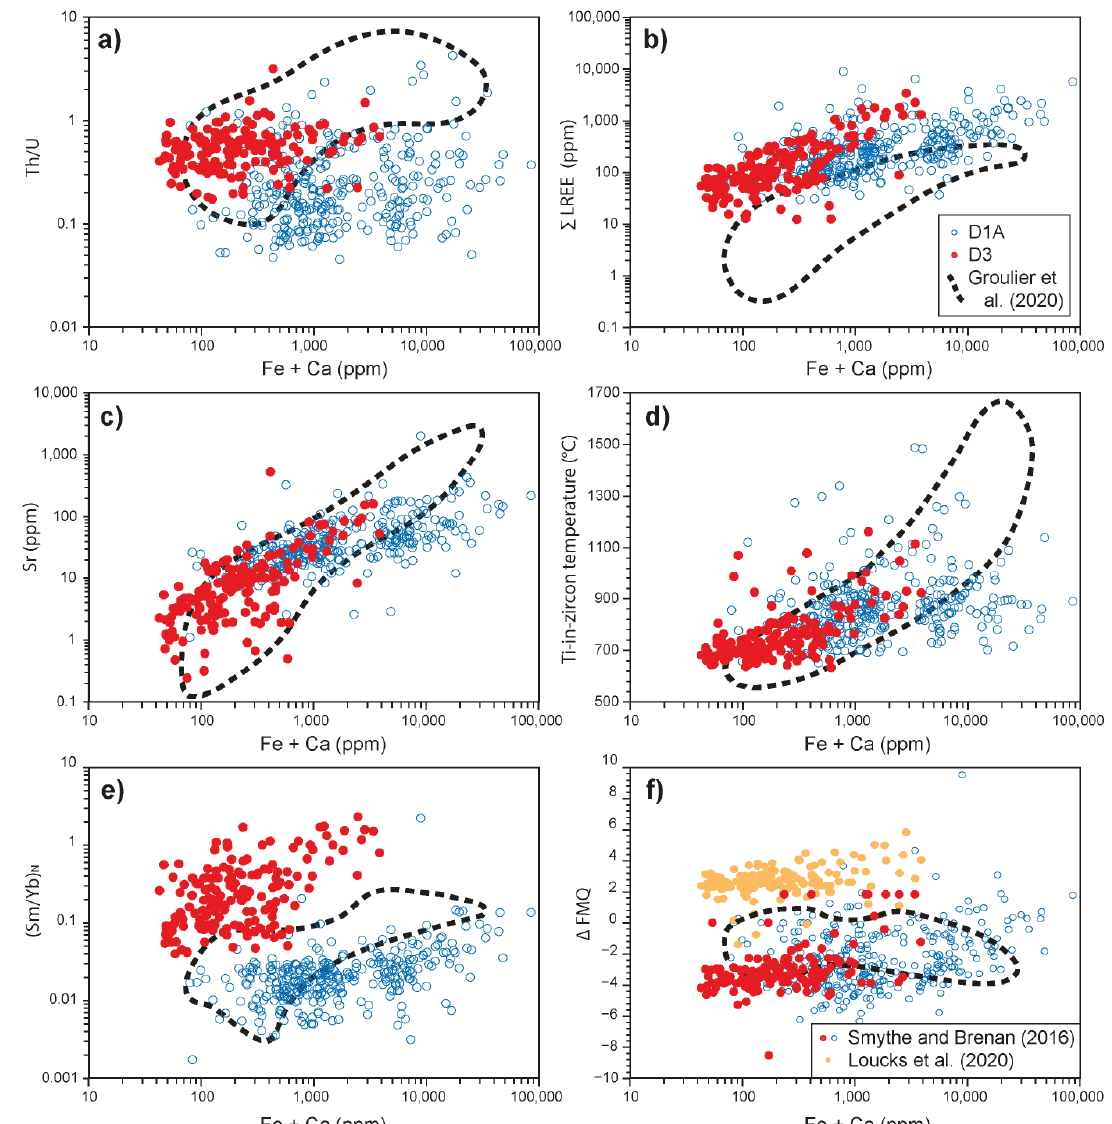
Figure 11. Chemical composition of the studied zircon grains displayed on the binary diagrams Fe + Ca vs. ( a ) Th/U, ( b ) sum LREE, ( c ) Sr, ( d ) temperature, ( e ) (Sm/Yb) N , and ( f ) oxidation state. Samarium and Yb were normalized to chondrite ( e ). The oxidation state was calculated for zircon using the methods of Smythe and Brenan [53] and Loucks et al. [54] ( f ). The dashed lines outline the range of compositions displayed by zircon grains from a carbonate-nepheline-bearing syenite sample from the Crevier complex [56]. For these samples, the oxidation state ( f ) was calculated using the method of Loucks et al. [54].